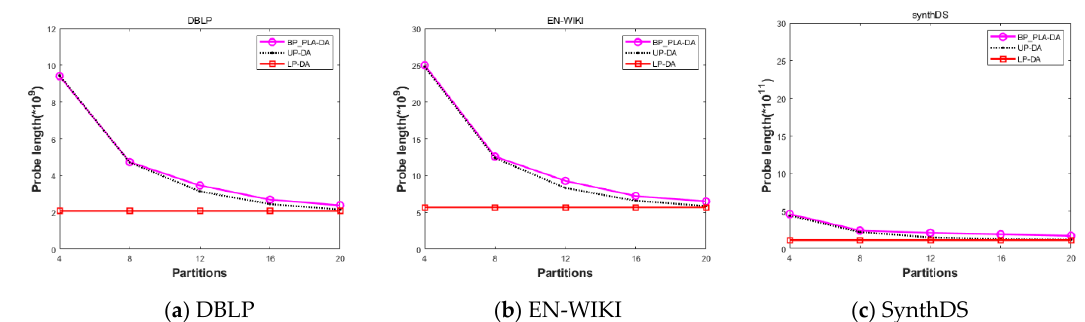
Figure 9. Total probe lengths for different partition numbers.